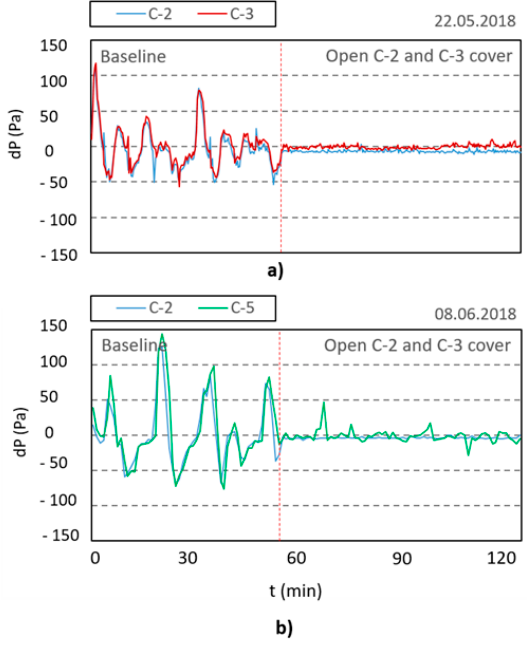
Figure 6. Comparison of pressure di ff erences between manholes and outside atmosphere with closed and open covers: ( a ) C-2 and C-3 and ( b ) C-2 and C-5, at R. das Flores trunk sewer for a 2 h period.